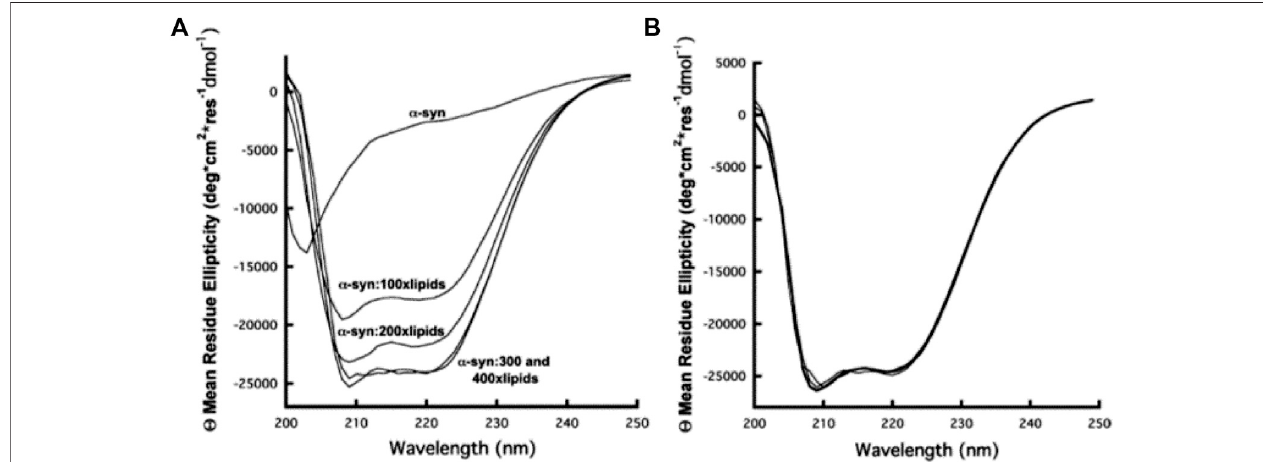
FIGURE 2 | (A) CD spectra of α -syn as a function of addition of lipid in the form of SUVs. From top to bottom, 10 μ M α -syn without lipids, 10 μ M α -syn with 1 mM lipids,10 μ M α -synwith2 mMlipids,10 μ M α -synwith3 mMlipids,and10 μ M α -synwith4 mMlipids,respectively.TheCDsignalintensityreachesamaximumatalipid: α -syn molarratioof300:1. (B) Cu 2+ titration ofthe10 μ M α -syn − 3 mM lipid complex. Cu 2+ concentrationsof0,10,and 100 μ M giveoverlapping α -synCD spectra. The fi gure and caption have been adapted with permission from Dudzik et al., (2013), Copyright © 2012 American Chemical